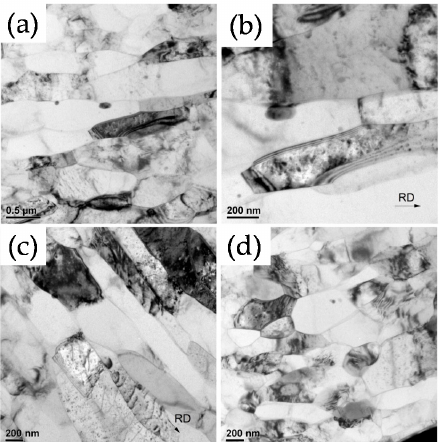
Figure 6. TEM micrographs of Al1050 alloy after asymmetric cryo-rolling: ( a ) and ( b ) SR of 1.1 for rolling direction (RD) at two different magnifications, ( c ) SR of 1.4 for RD, ( d ) SR of 1.4 for TD (RD: rolling direction; TD: transverse direction) [ 43 ].